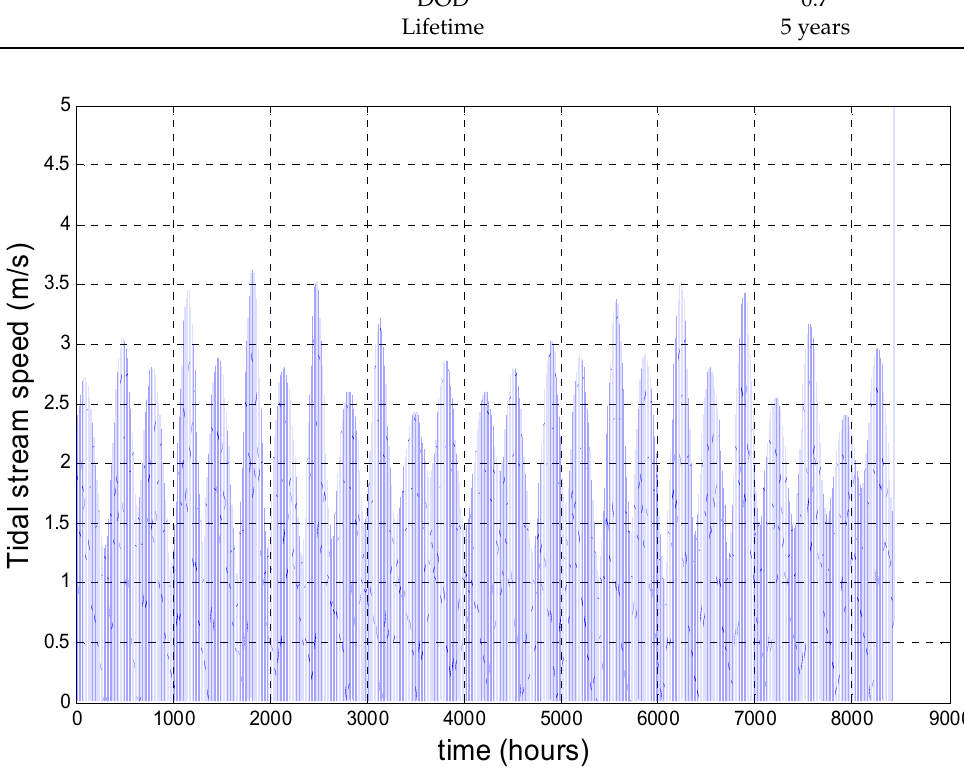
Figure 5. Tidal velocity for one year.